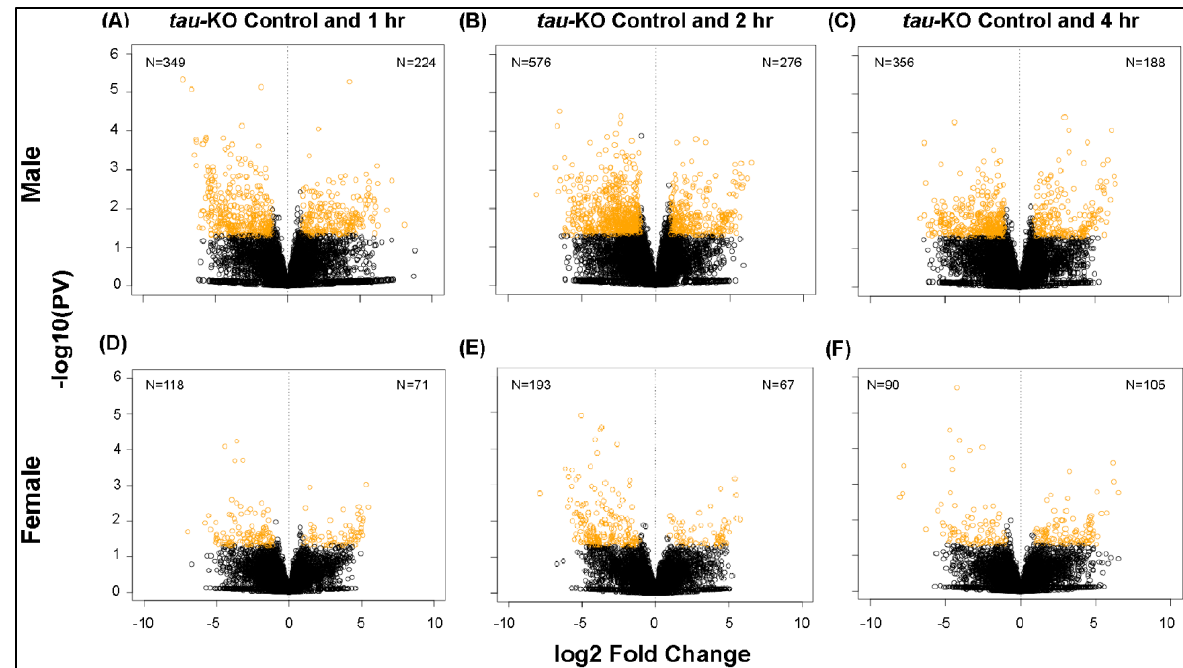
Figure 3. Transcriptional changes after TBI in tau -KO male and female flies. Volcano plots depicting log2 fold change and – log10 (PV: p -value) of differentially expressed genes at 1, 2 and 4 h after injury compared to control are indicated for males ( A – C ) and females ( D – F ) (n = 3 for each condition: male and female at control, 1, 2 and 4 h post-TBI).The number of significantly upregulated and downregulated gene changes are indicated in yellow in each plot (|log2FC| > 1; p -value < 0.05). Tau -KO males show more transcriptional upregulation of genes in response to injury than females.